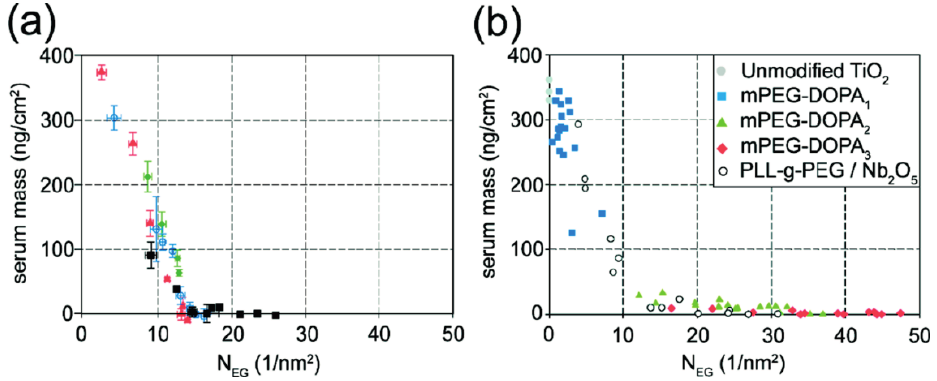
Figure 7. A “master curve” compiled for the efficiency of different anchoring strategies and PEG spacers with respect to preventing serum protein adsorption. A mono-, di-, or trivalent DOPA or a PLL-chain multivalent anchor was used. These combined results from several studies for short linear and dendron PEG show that serum protein adsorption is prevented above a cut-off projected surface density of ~15 EG units ( N EG ) per nm 2 , regardless of architecture. ( a ) Comparison of dendron (D(valency of anchor)) and linear PEG (L(valency of anchor) with a molecular weight of the PEG part of M w = 2.5 kDa): D( n = 1), green diamond, D( n = 2), red triangle, D( n = 3), blue circle, and L( n = 3), black square; ( b ) Comparison of PEG-5 kDa-DOPA (D( n = 1–3)) (on TiO (on Nb O ) 2 5